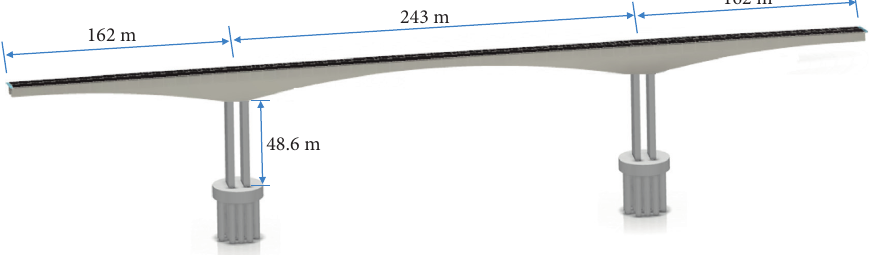
Figure 1: Three-dimensional layout of a rigid frame bridge.